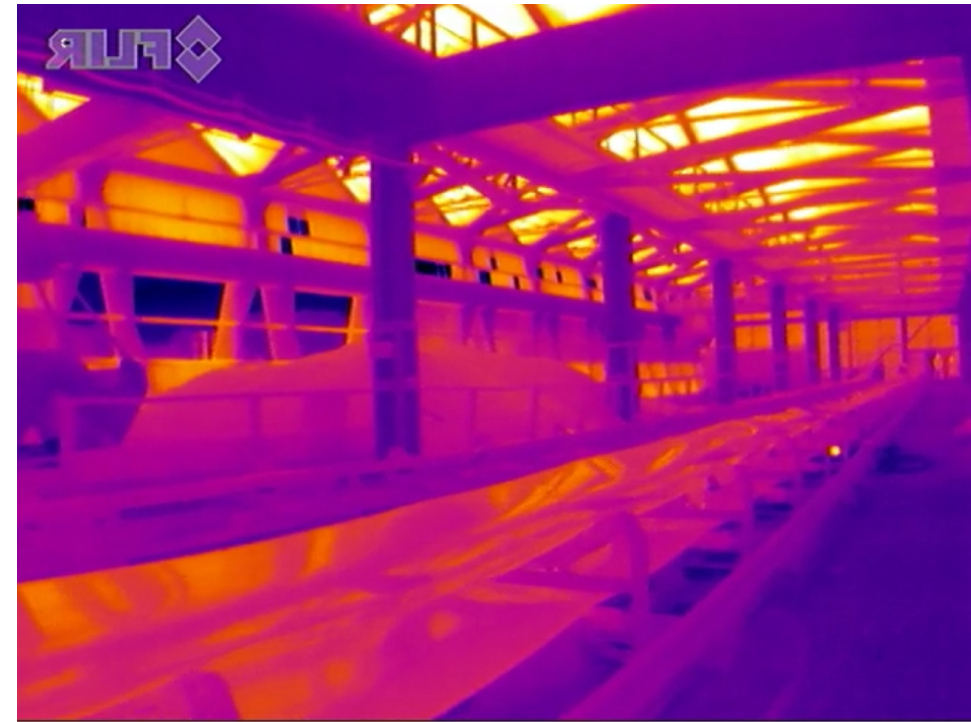
Figure 4. Example of IR